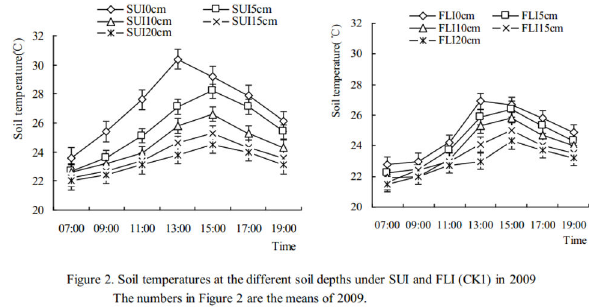
Figure 2. Soil temperatures at the different soil depths under SUI and FLI (CK1) in 2009.